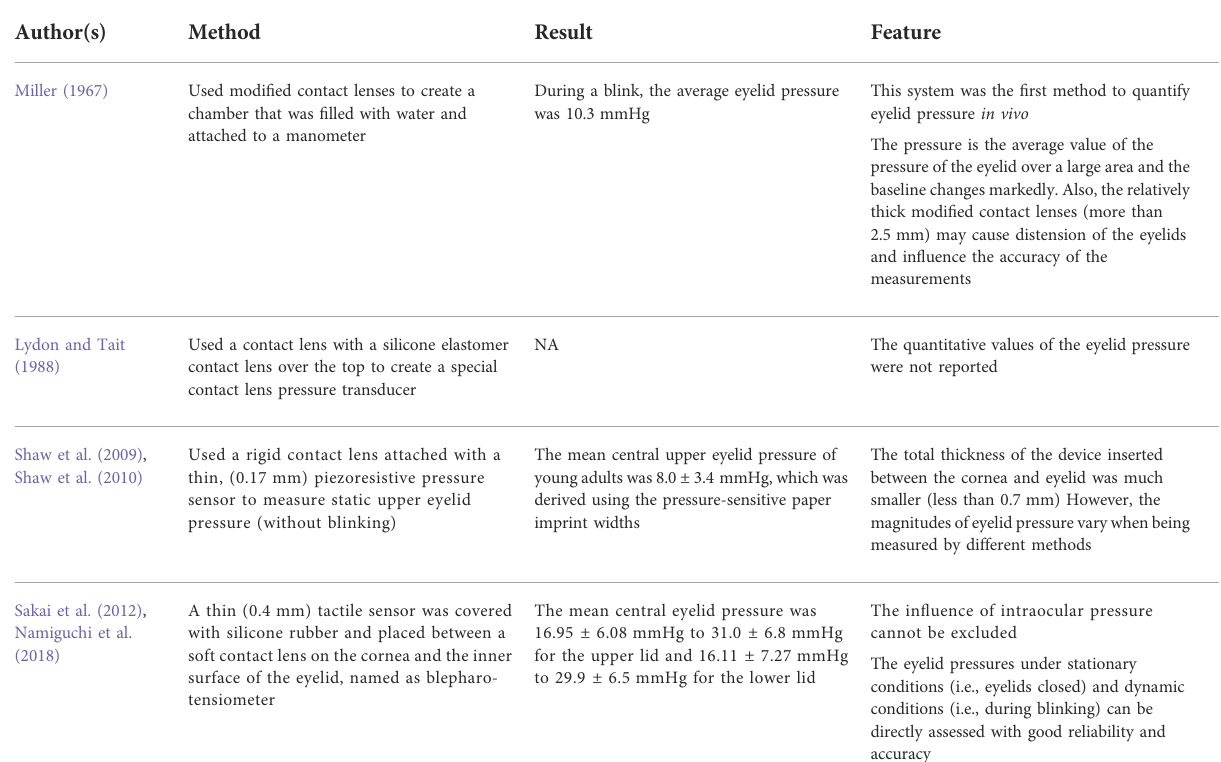
shear stress on the corneal endothelium (lower panel in Figure 2). It is dif fi cult to directly measure the shear stress produced by AH. Thus, several numerical calculations of AH dynamics have been developed to delineate the fl ow patterns and distributions of shear